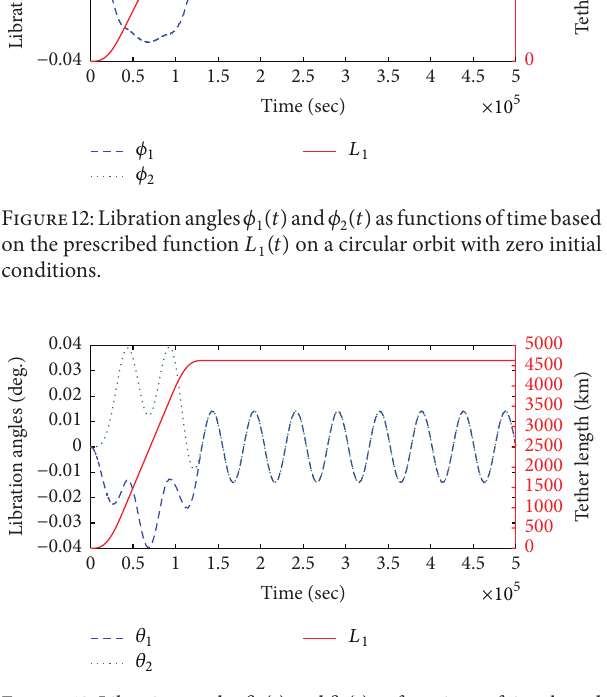
Figure13:Librationangles 𝜃 1 (𝑡) and 𝜃 2 (𝑡) asfunctionsoftimebased on the prescribed function 𝐿 1 (𝑡) on a circular orbit with zero initial conditions.